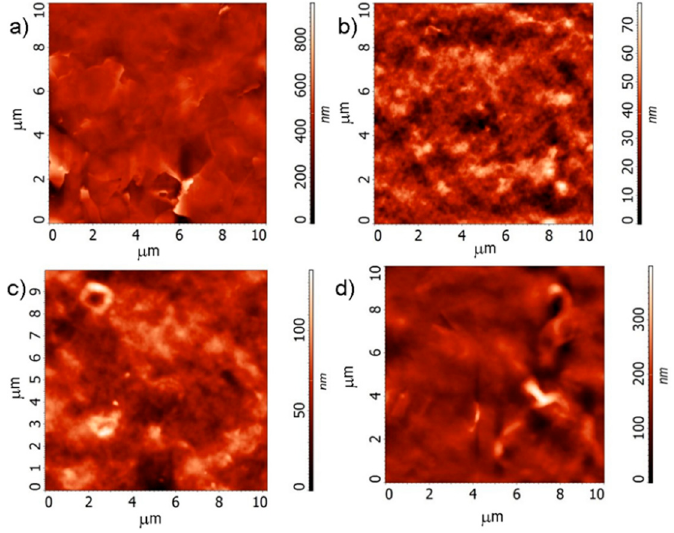
Figure 2. AFM images of the surface of the films printed from a suspension of graphene ( a ), PEDOT: PSS ( b ), ( c , d ), and C1c and C1a1 composites ( c and d , respectively).